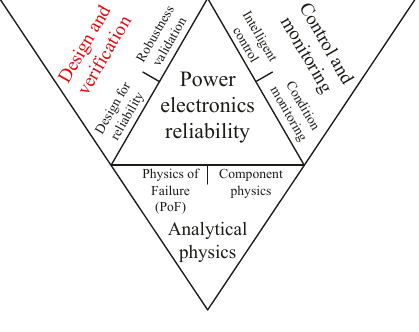
Fig. 2. Aspects in power electronics reliability assessment